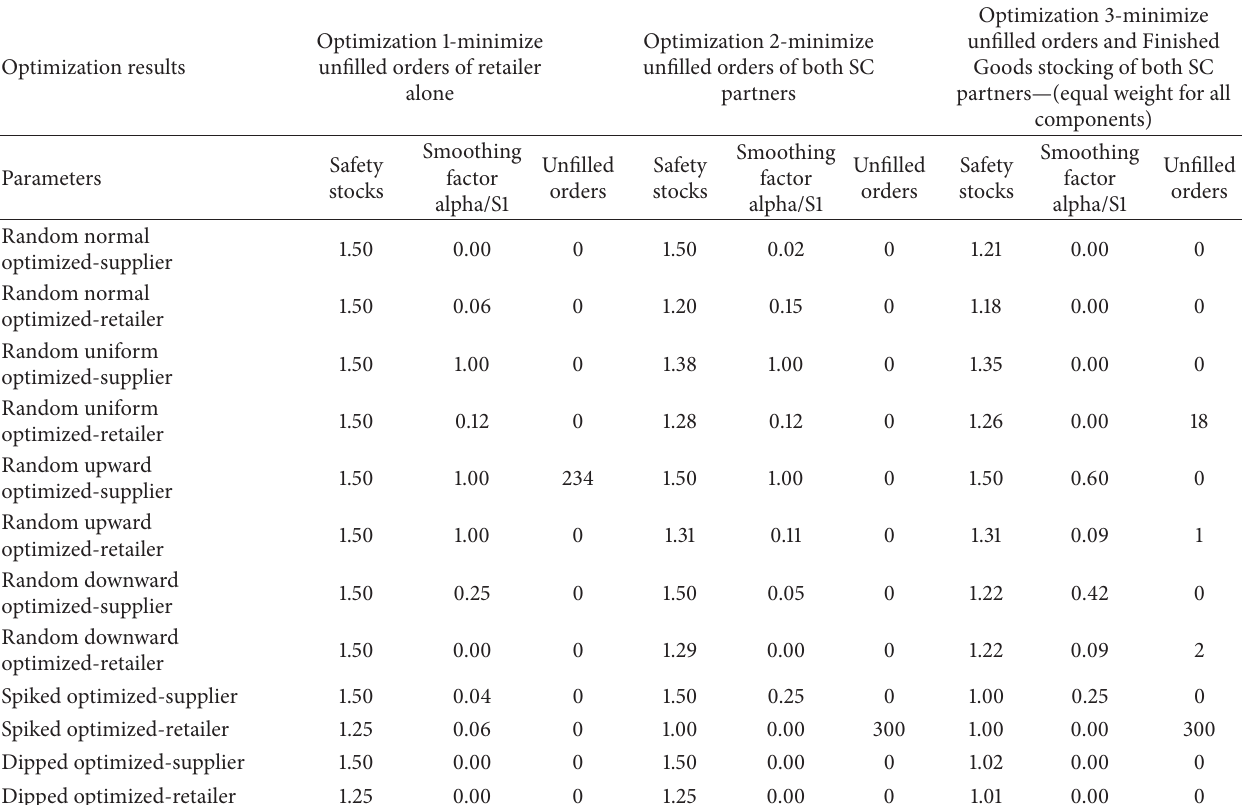
Table 4: Parameter settings and results from optimization